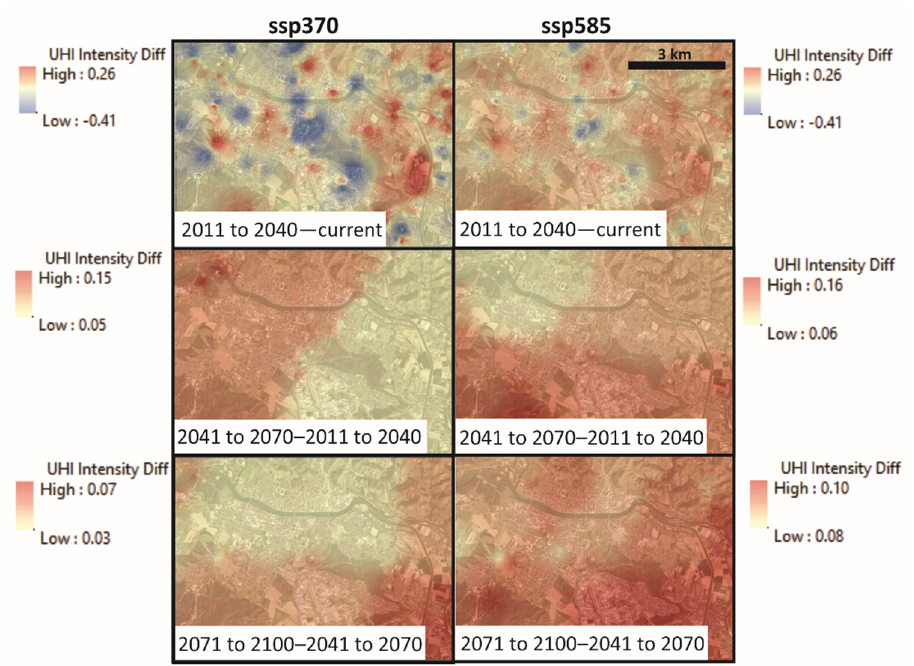
Figure 6. Future UHIi in Maribor. Differences between considered time windows (in °C) per ssp scenario.